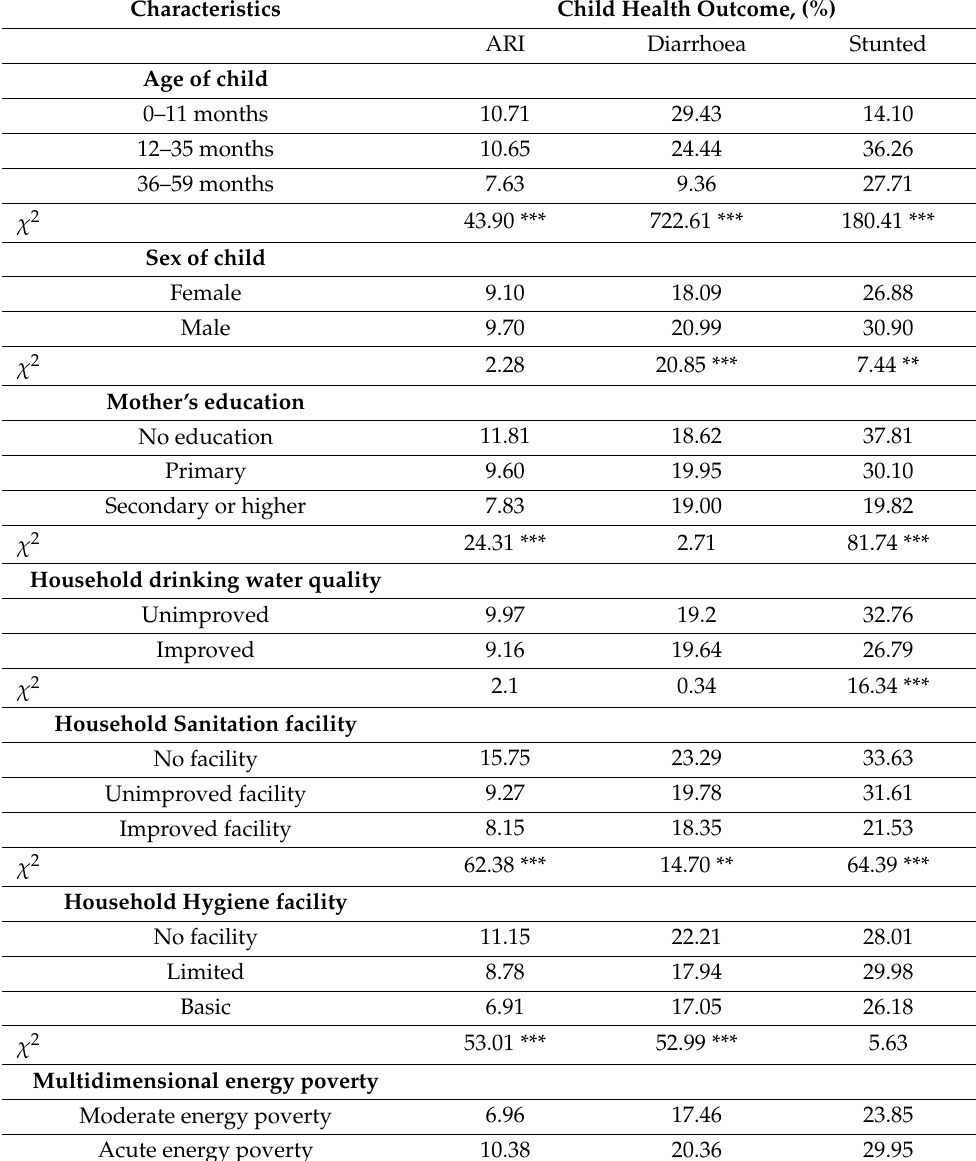
Table 4. Sociodemographic characteristics by health outcomes of children along with the χ 2 tests of association.